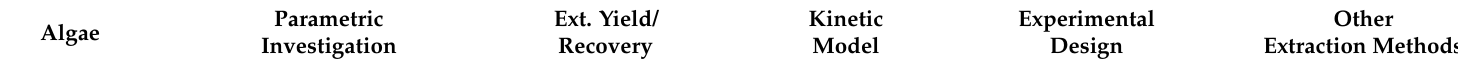
Table 3. Experimental design and kinetic modeling of SFE and other extraction methods compared to